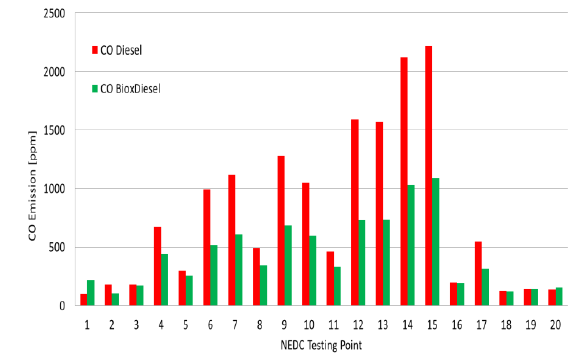
Fig. 8. Emission of carbon monoxide (CO) from the engine fed with Bioxdiesel and Diesel fuels